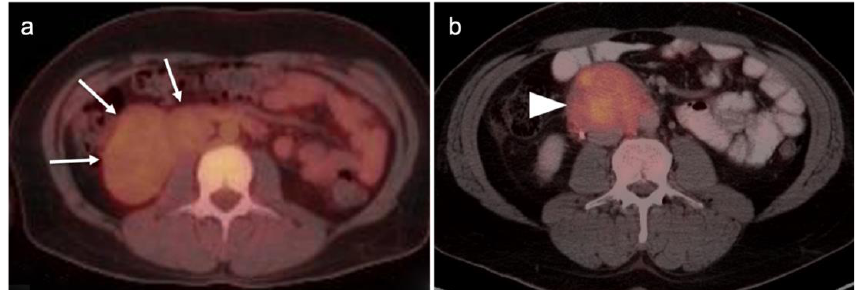
Figure 42. Two cases of large pure seminoma demonstrating variability in metabolic activity in retroperitoneal masses on FDG PET-CT. ( a ) An axial FDG PET-CT image shows a large tumor with relatively mild uptake (white arrow), relative to background muscle and other tissues; ( b ) Another large retroperitoneal site of seminoma with more intense metabolic activity is shown on FDG PET-CT (white arrowhead).